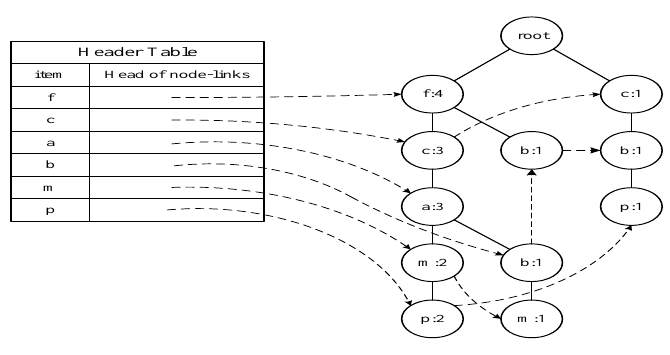
Figure 4. An example of